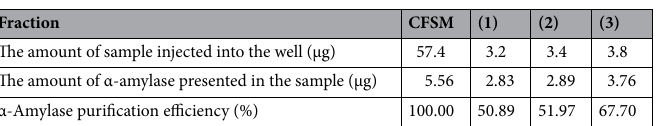
Table 3. Results of SDS-PAGE analysis based on semi-quantitative analysis with quantity one software.